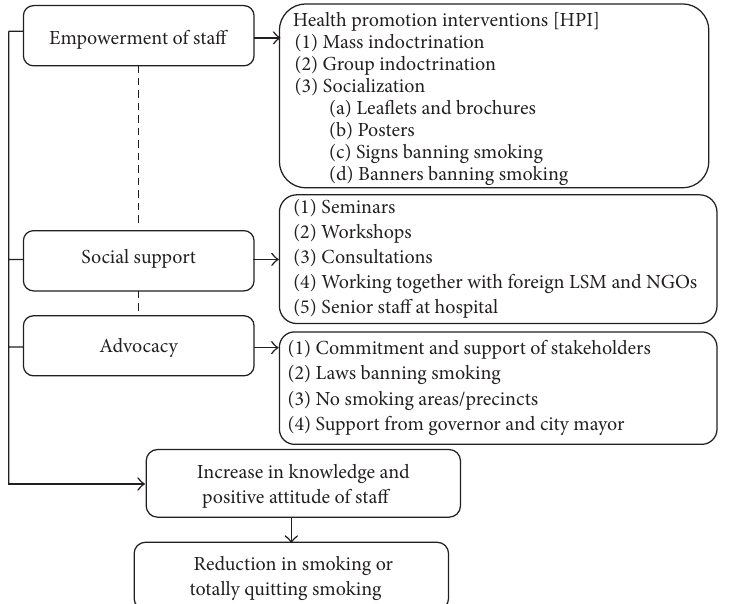
Figure 1: Model for change in smoking behavior of staff at RSUZA Hospital. Strategy for increasing knowledge, improving attitudes, and changing smoking behavior amongst the staff at the RSUZA